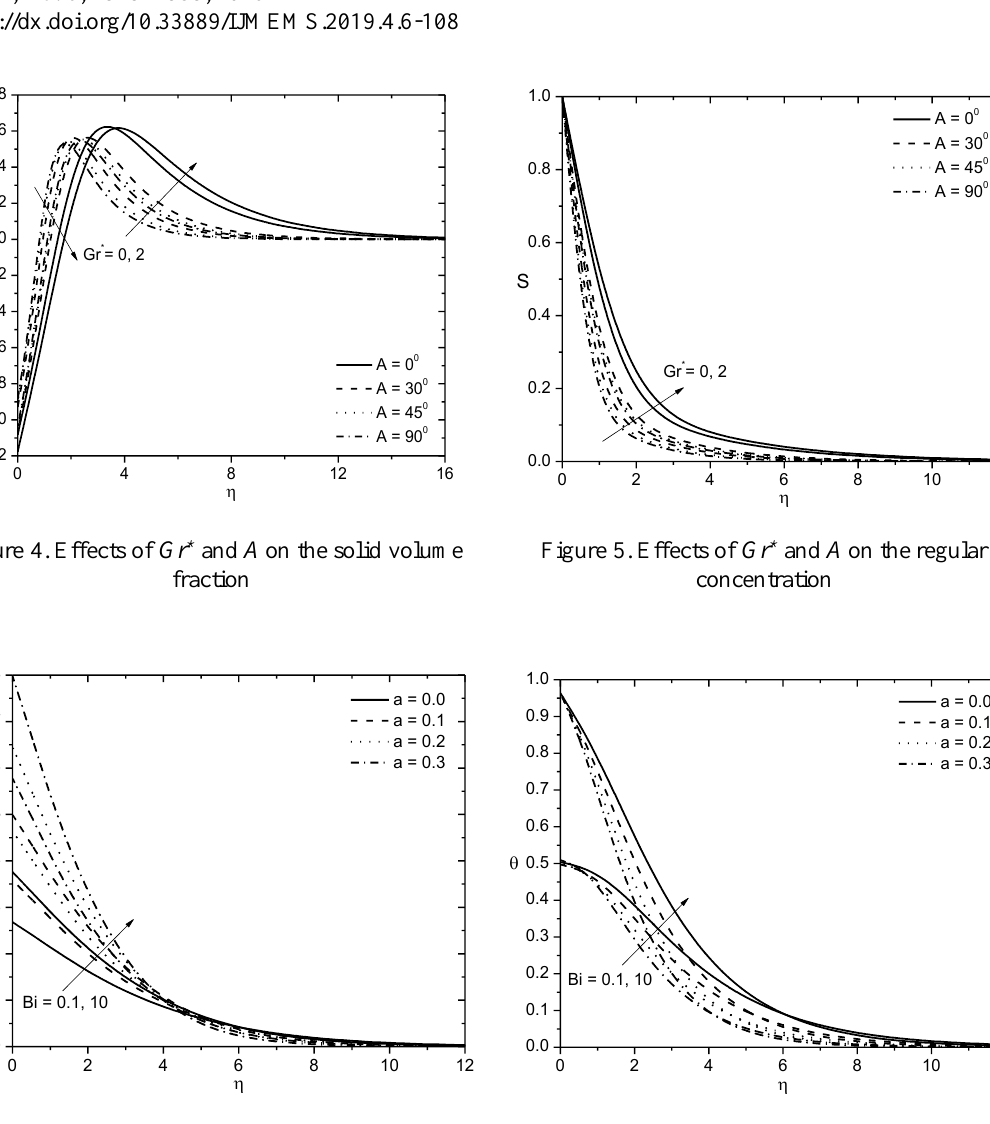
Figure 6. Effects of Bi and a on the velocity Figure 7. Effects of Bi and a on the